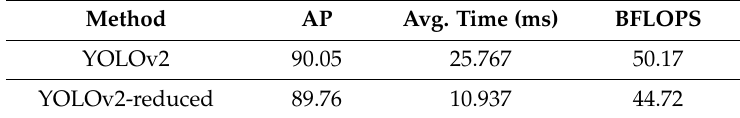
Table 9. Average Accuracy and Speed Comparison between YOLOv2 and YOLOv2-reduced